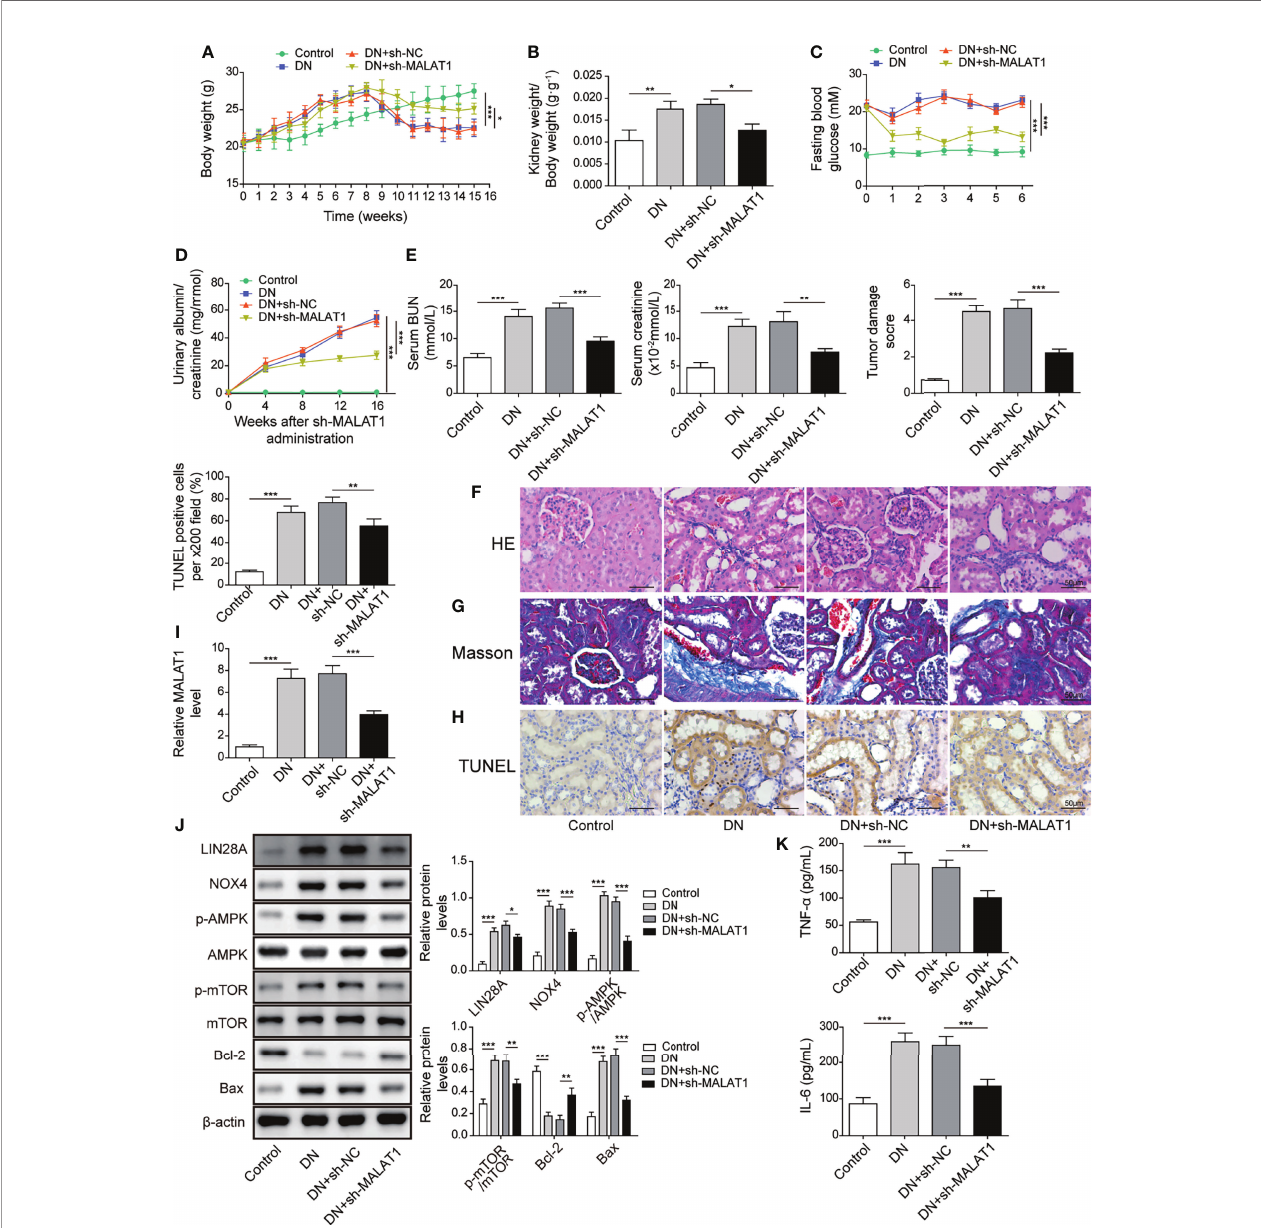
FIGURE 9 | Knockdown of MALAT1 alleviated renal tubular injury by suppressing LIN28A and the Nox4/AMPK/TOR signaling axis in rats with DN. SD rats with DN were intravenously injected with shMALAT1 lentiviral particles and sequentially fed a high glucose and fat diet for 5 months. (A) Body weight of rats (n=6 each group). (B) Kidney to body weight ratio (n=6 each group). (C) Fasting blood glucose (n=6 each group). (D) Urinary albumin to creatinine ratio (n=6 each group). (E) The concentration of BUN and creatinine in serum (n=6 each group). (F) H&E staining of kidney sections (Scale bar=50 µM). (G) Masson ’ s Trichrome staining of kidney sections (Scale bar=50 µM). (H) TUNEL staining for cell apoptosis analysis in kidney sections (Scale bar=50 µM). (I) qRT-PCR analysis of MALAT1 in the kidneys (n=6). (J) Protein levels of LIN28A, Nox4, p-AMPK, AMPK, p-mTOR, mTOR, Bcl-2 and Bax in the kidneys (n=6). (K) The concentrations of TNF- a and IL-6 in serum (n=6). * P < 0.05, ** P < 0.01 and *** P <